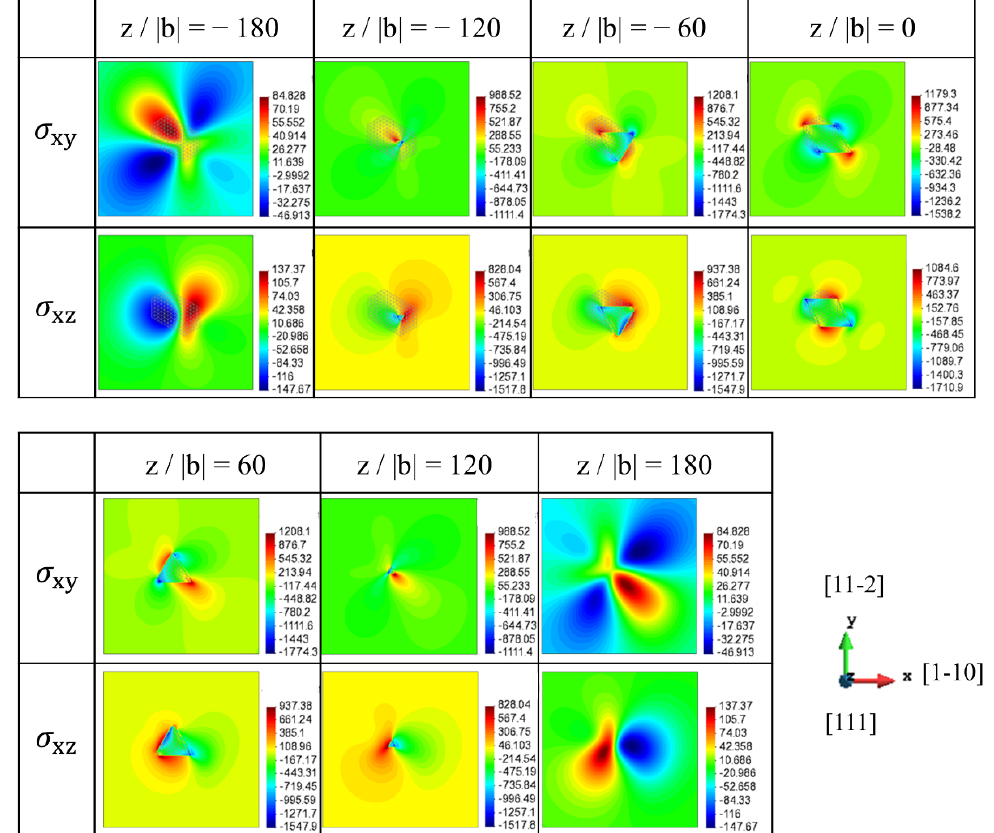
and in disloca- 𝜎𝜎 xy 𝜎𝜎 xz